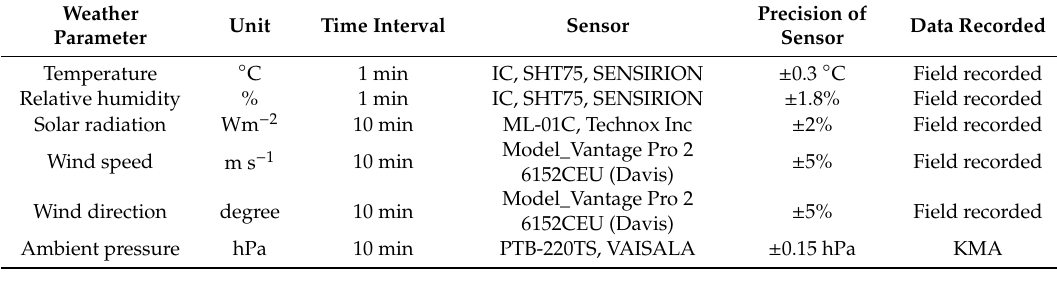
Table 1. Weather data variables used in the simulations.